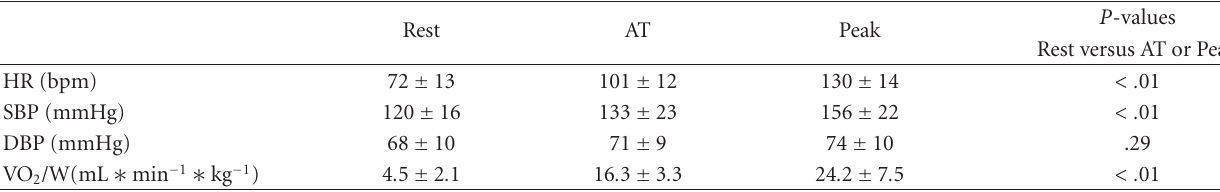
Table 2: The summary of the selected parameters obtained from VEST system. P -values Rest AT Peak Rest versus AT or Peak EF (%) 54 ± 12 65 ± 16 57 ± 10 < . 01 PER (EDV0 ∗ sec − 1 ) 3 . 1 ± 0 . 9 < .